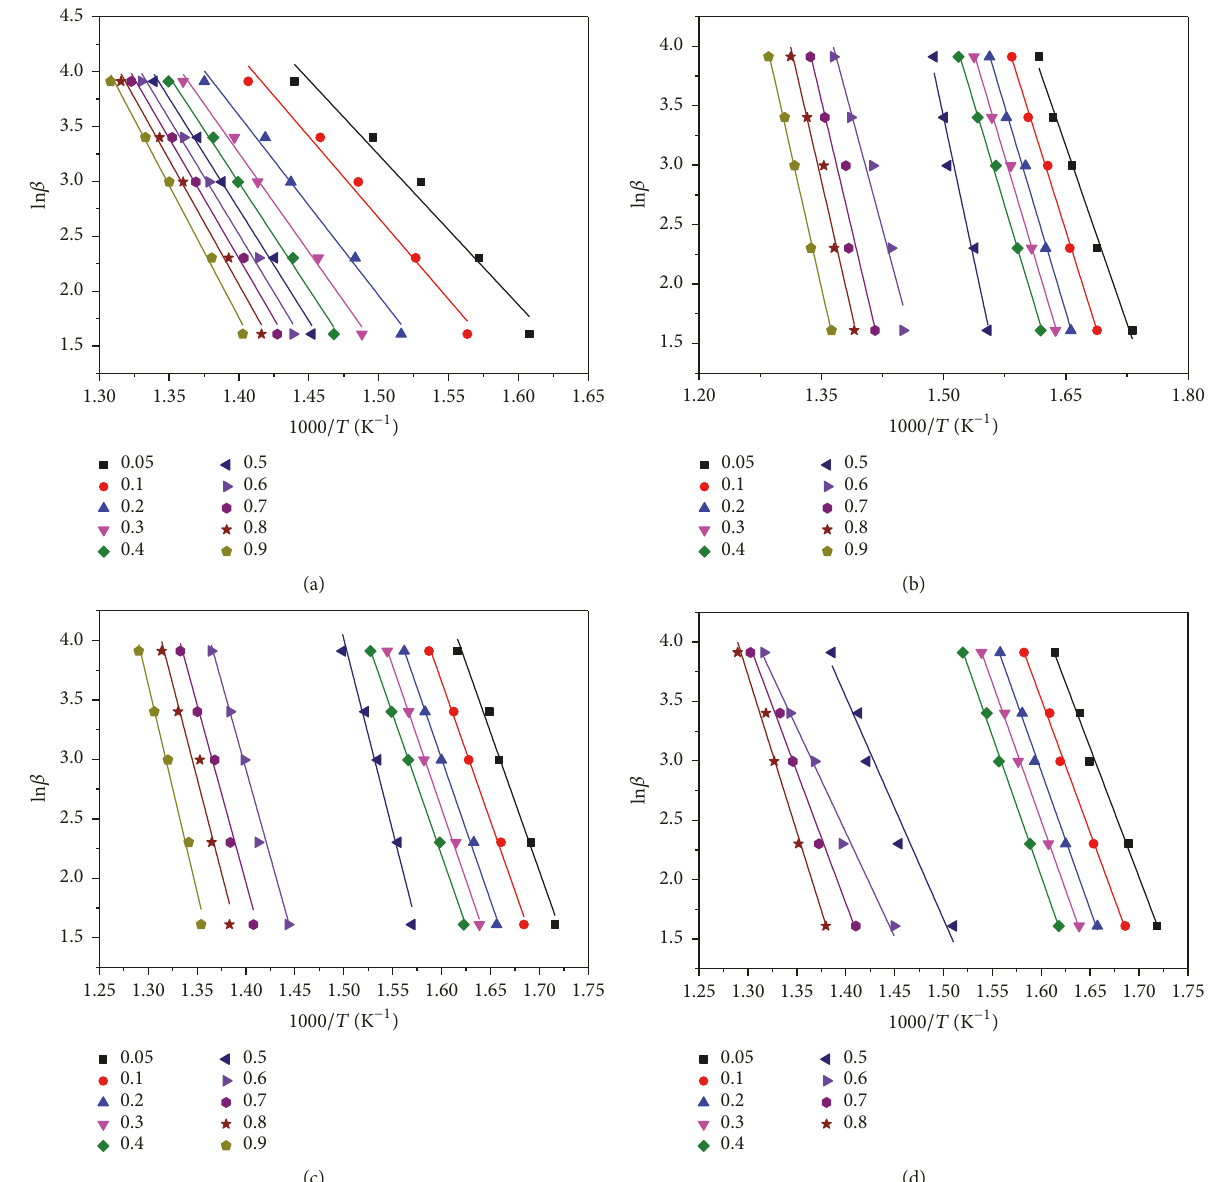
Figure 5: The curves of ln (𝛽) -1000/ T of rPP and its composites: (a) pure rPP, (b) MCC/rPP (60/40), (c) MCC/PP-g-MA/rPP (60/5/35), (d)